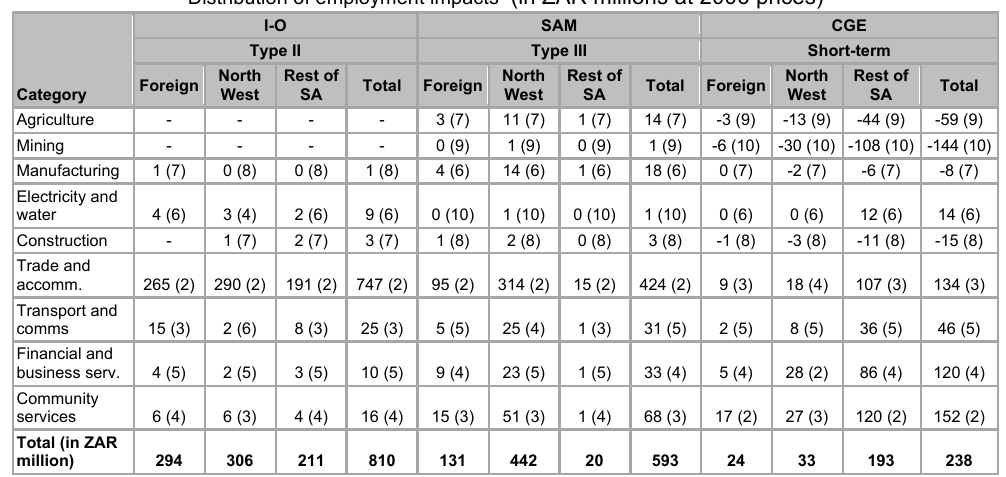
Distribution of employment impacts (in ZAR millions at 2006